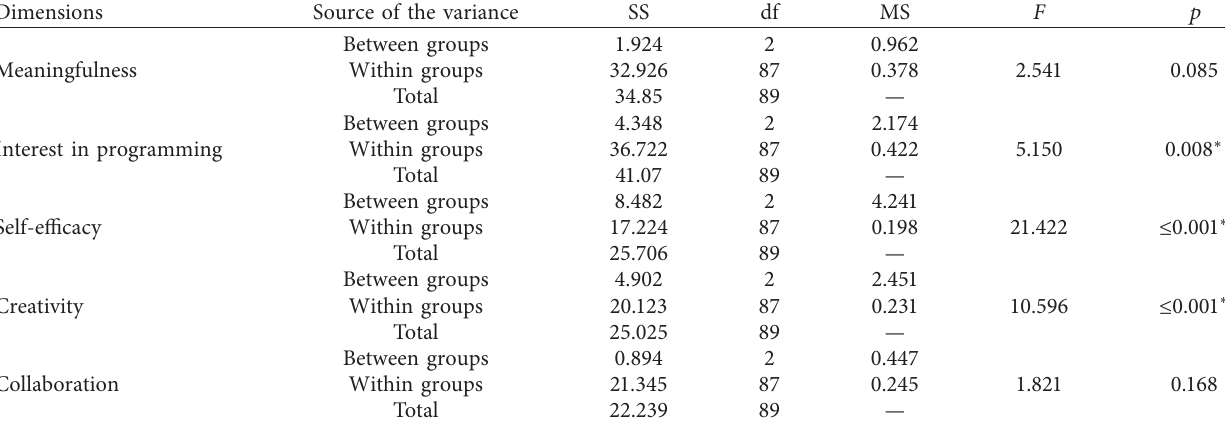
Table 8: Analysis of variance (ANOVA) results among different learning performances in each dimension.